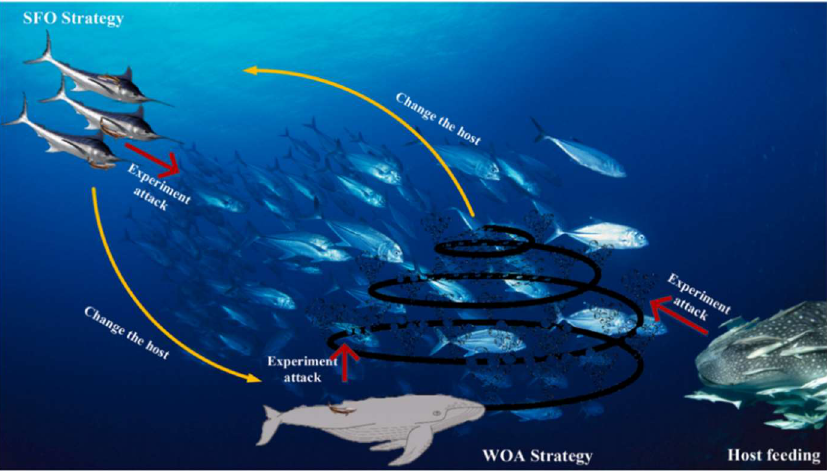
Figure 1. The different states of ROA.